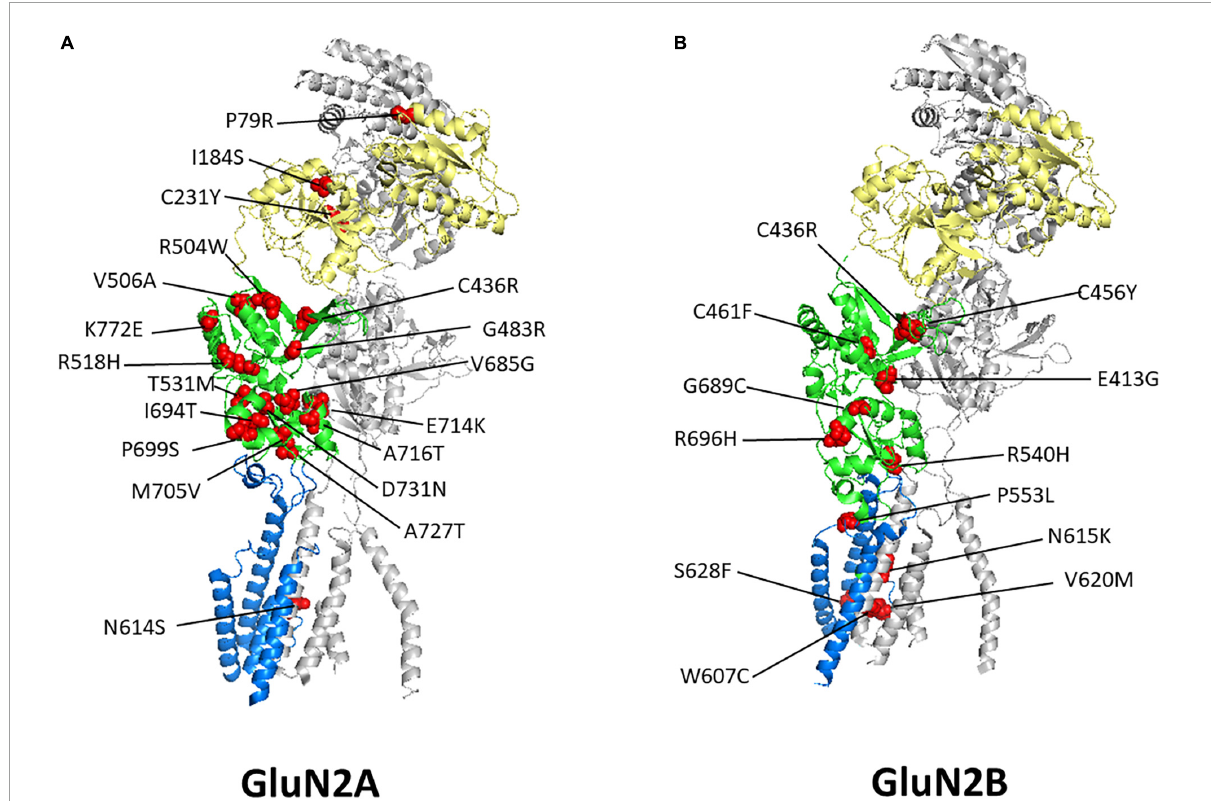
FIGURE2 Disease-associated variant locations within GluN2 Subunits. Shown are heterodimer structures of half of an NMDAR containing one GluN1 subunit, in gray, and one GluN2A subunit (A) or one GluN2B subunit (B) , with the ATD in yellow, LBD in green, and TMD and linkers in blue. Disease-associated variants with reduced surface expression are shown as spheres and highlighted in red. GluN2A PDB: 7EU7 (Zhang Y. et al., 2021) GluN2B PDB: 6WHS (Chou et al., 2020). See Table 1 for details regarding these variants clinical phenotypes and functional